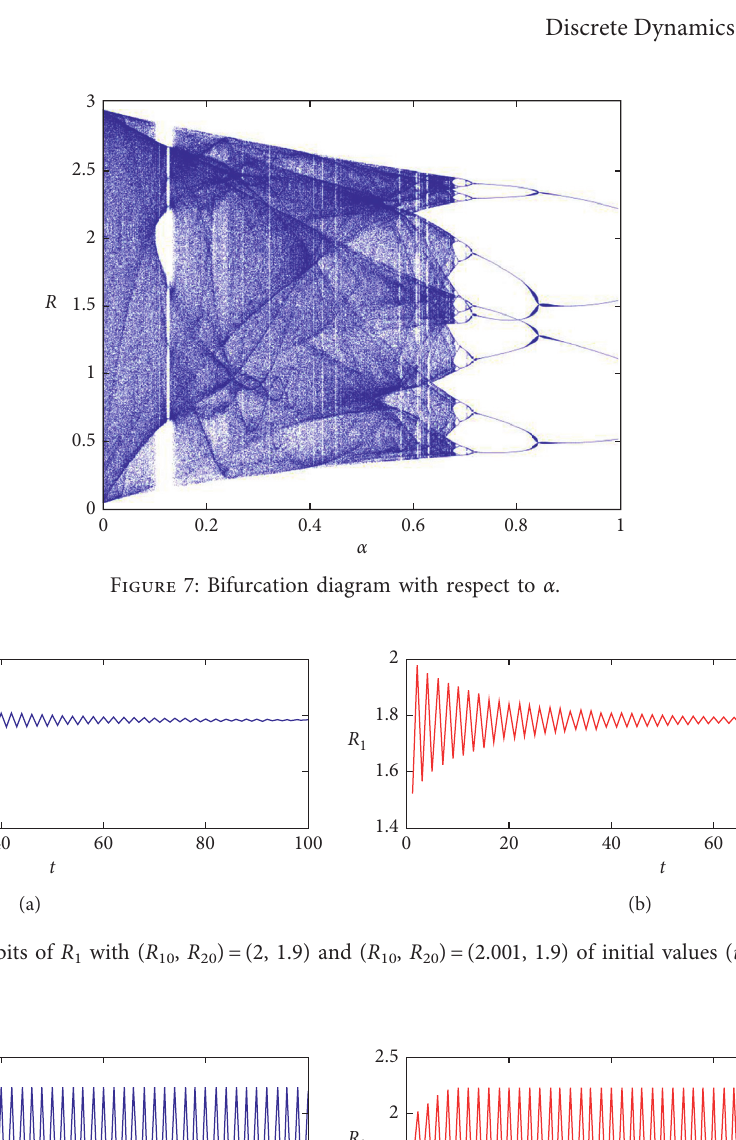
� (2.001, 1.9) of initial values ( u 10 , R 20 )